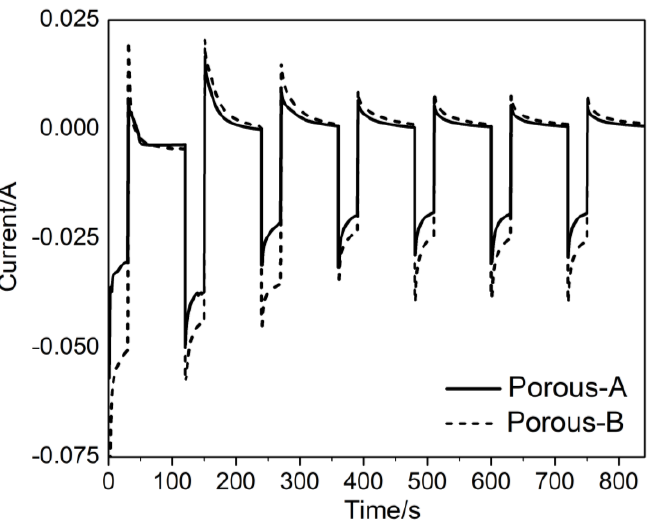
Figure 3. Pulsed potentiostatic transients recorded during the deposition of FePd NWs on AAO templates of 20 and 100 nm in diameter, both for E on = – 1.2 V.